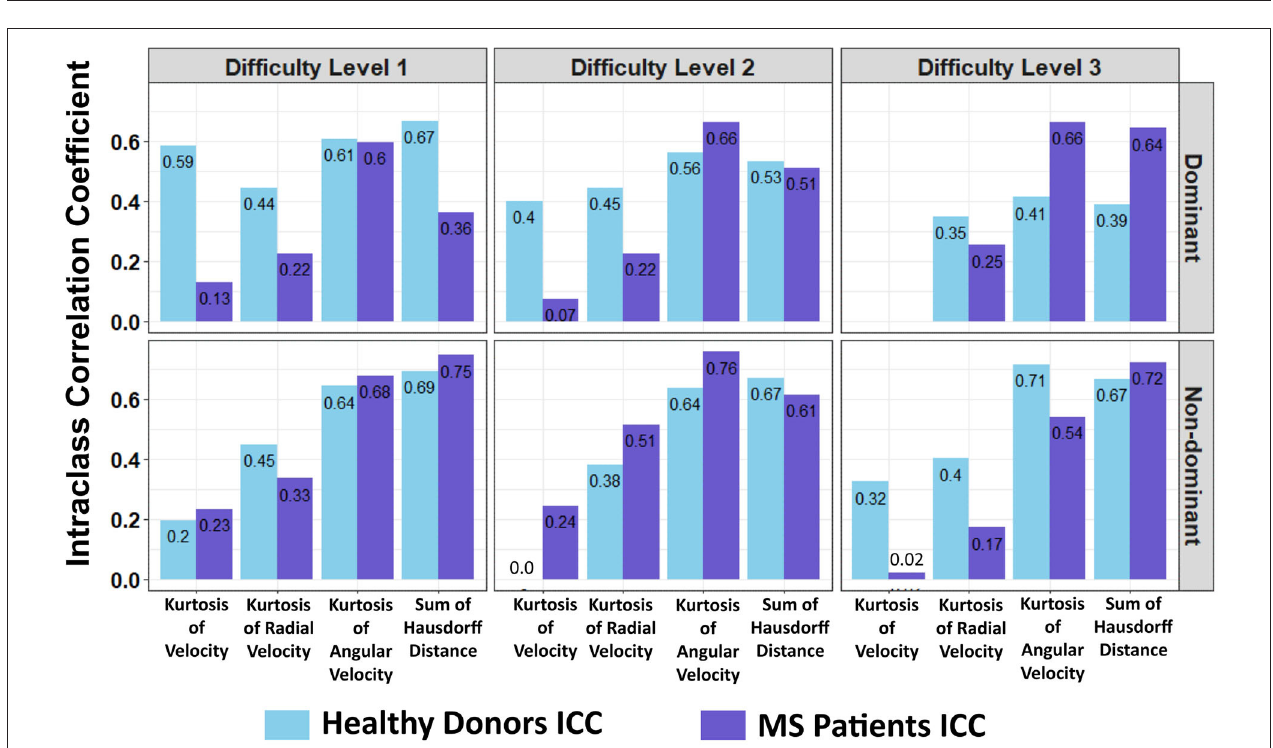
FIGURE 8 | Comparison of the intraclass correlation coefficient (ICC) calculated from the granular data of the healthy vs. MS cohorts. The x -axis represents spiral-derived features with FC > 2 and ICC > 0.5 while the y -axis is the ICC (MS indicates multiple sclerosis patients).